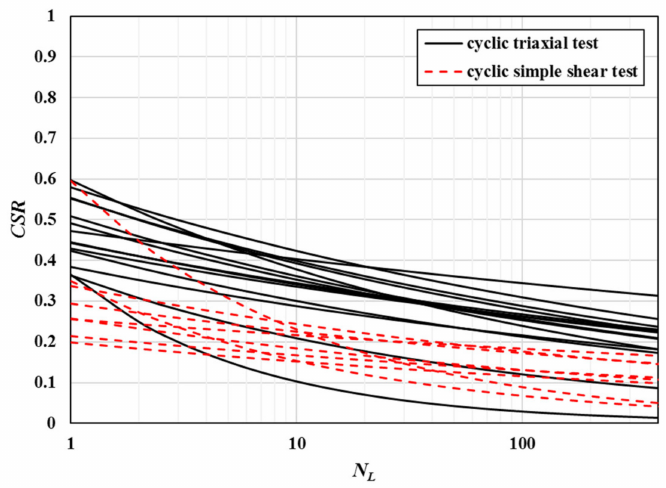
Figure 5. The resistance curve of the laboratory